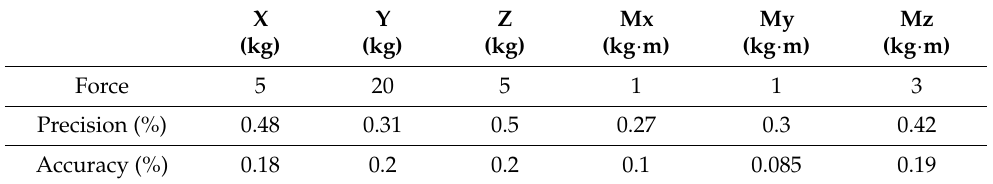
Table 1. Measurement range, calibrated precision, and accuracy of the